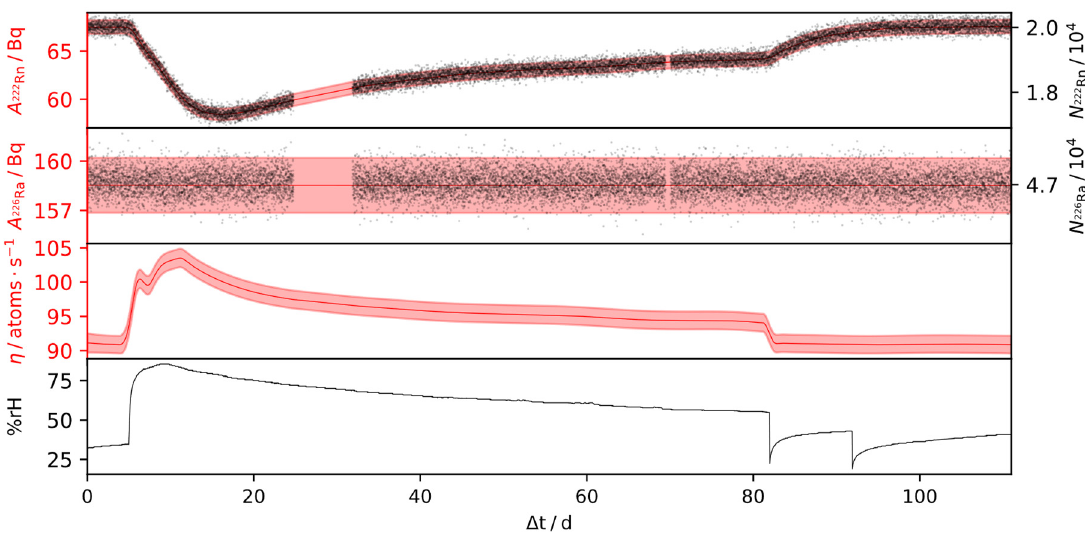
Figure 7. SLDS-deconvolution result for a IRSD of approx. 160 Bq 226 Ra. Black dots represent the determined peak areas of a set of approx. 15,000 spectra, taken over 110 days at a sampling interval of 600 s of 222 Rn and 226 Ra, respectively. Red curves represent the smoothed results for the residual 222 Rn- and 226 Ra activities and the deconvolved time-series of the emanation (cid:2015) , according to Section 2.5. Shaded areas represent the 1 (cid:2026) credible intervals, almost entirely caused by the systematic uncertainty.